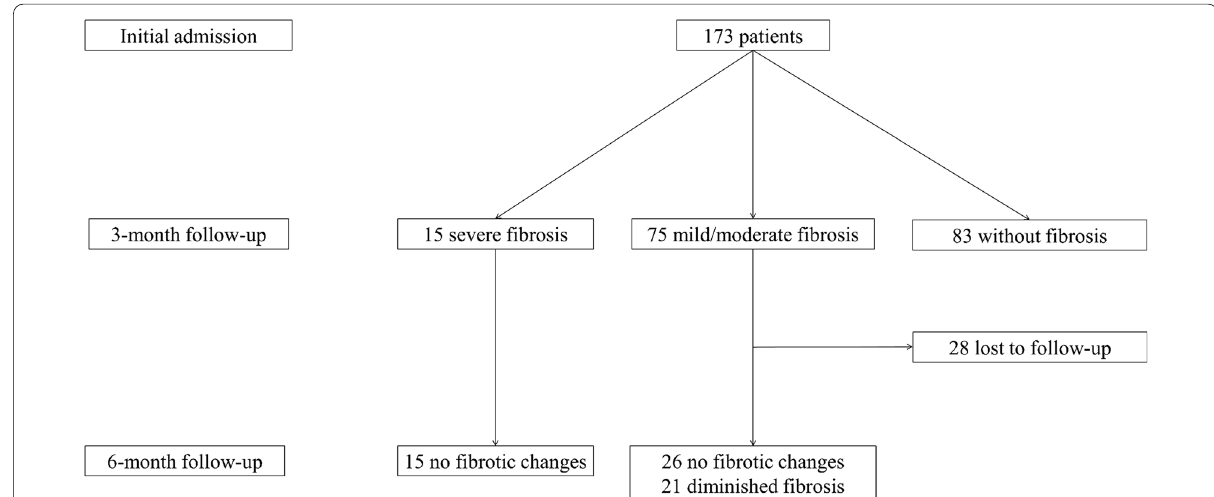
Fig. 1 Lung fibrotic-like changes in the COVID-19 patients at different follow-ups